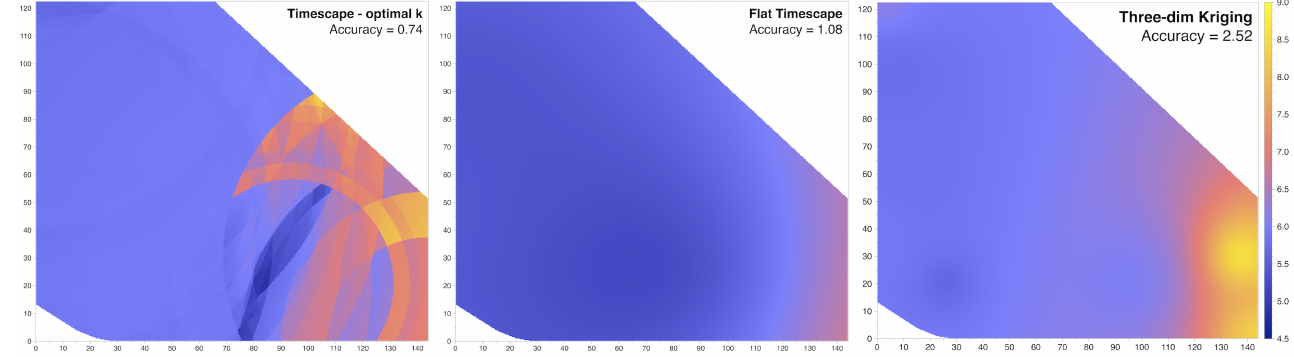
Figure 13. The topmost sheet of three models. ( Left ): fine-tuned Timescape, i.e., the topmost horizontal sheet of predicted values (cid:98) Φ ( x ) (top right of Figure 12). ( Center ): the loosest possible Timescape. ( Right ): three-dimensional